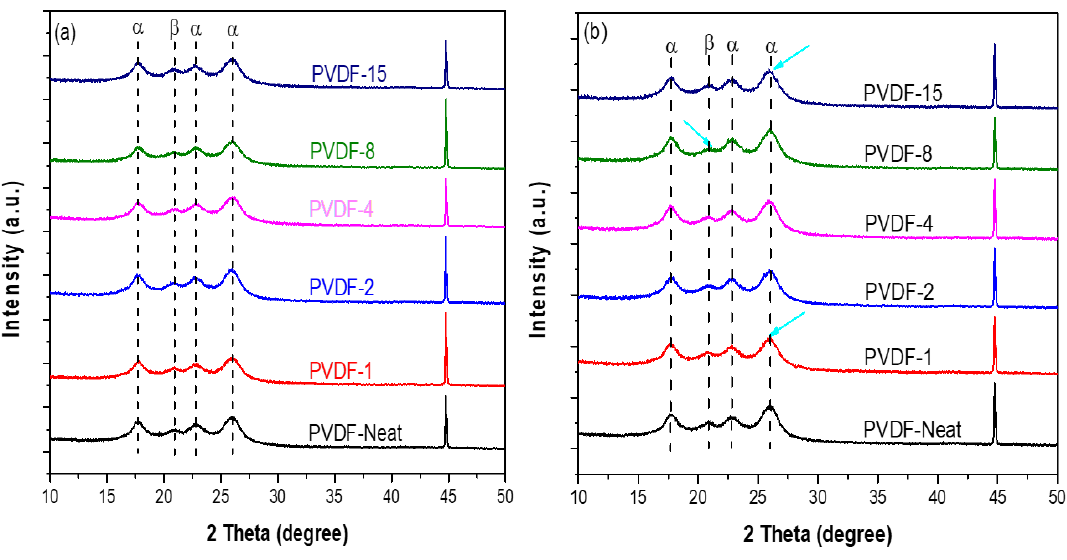
Figure 4. XRD crystalline phase analysis of neat and embedded membranes at exposure periods of ( a ) 7 days (representing the minimum exposure period) and ( b ) 112 days (representing the maximum exposure period).